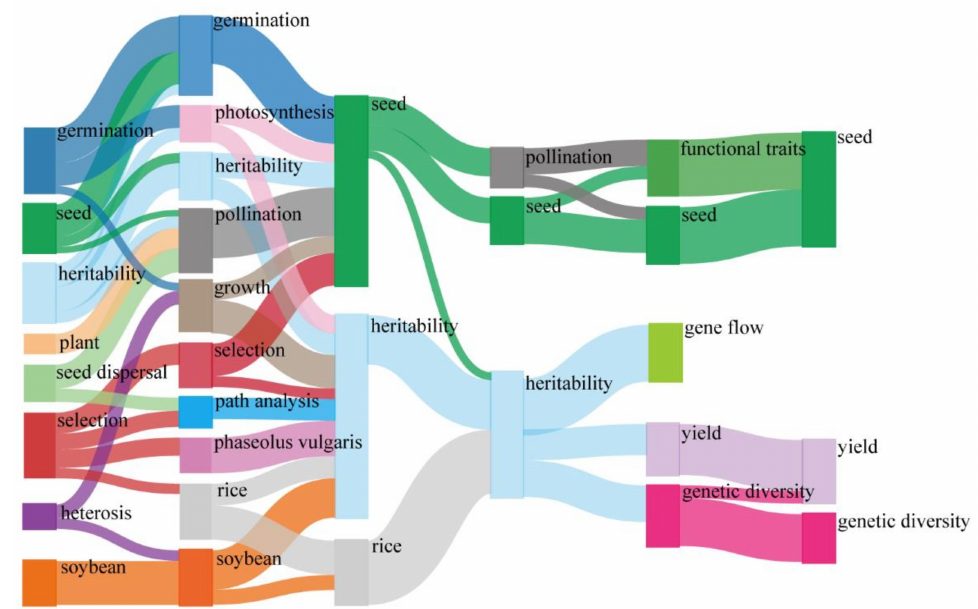
Figure 8. The temporal evolution of popular keywords on seed traits (ST) study. The horizontal axis represents the year. Each node represents a popular keyword, and the size of each node is proportional to its reference frequency. The lines between each node represent the time evolution of keywords. These lines reflect the transfer between keywords and the relationship between heritability. Different colors represent different